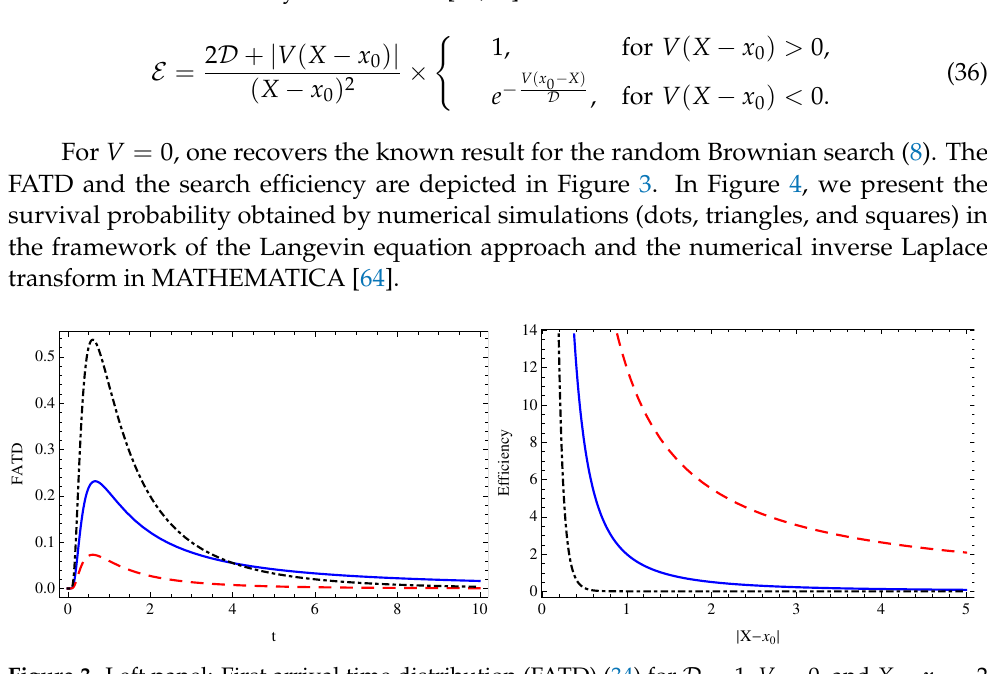
Figure 3. Left panel: First arrival time distribution (FATD) (34) for D = 1, V = 0, and X − x 0 = 2 (blue solid line), V = 1 and X − x 0 = − 2 (red dashed line), and V = 1 and X − x 0 = 2 (black dot-dashed line). Right panel: Efficiency (36) for D = 1 and V = 0 (blue solid line), v = 10 and X > x 0 (red dashed line), and v = 10 and X < x 0 (black dot-dashed line).